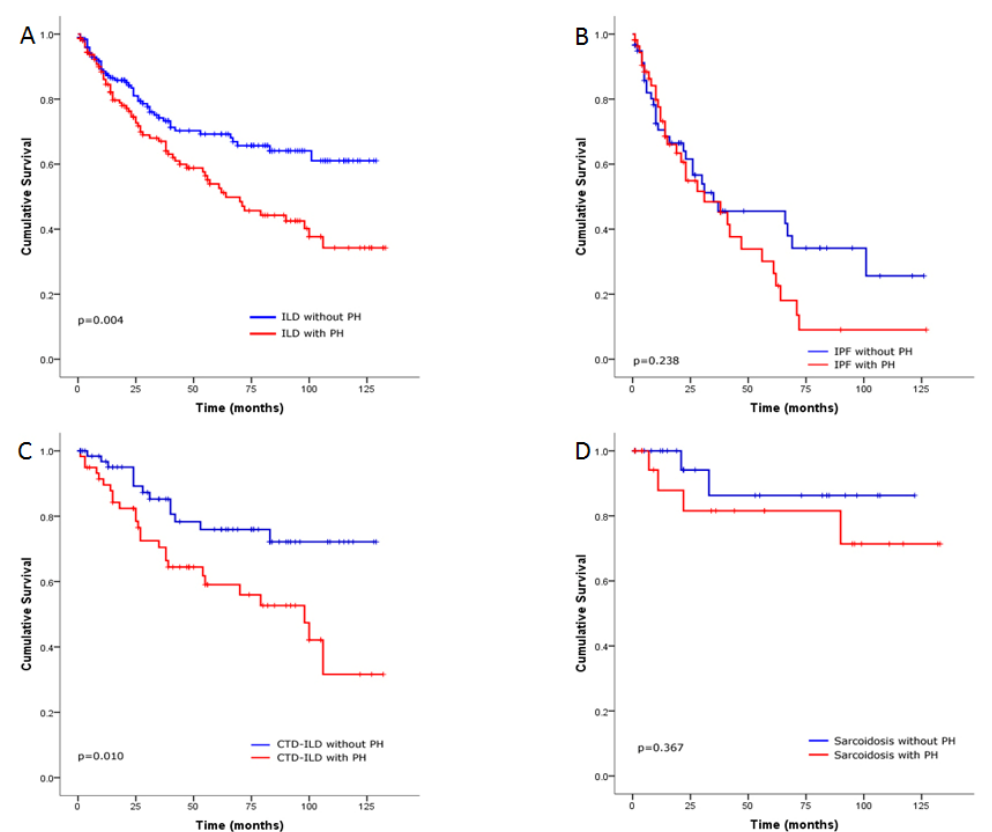
Figure 1. Kaplan–Meier survival estimates for the relationship with ( A ) interstitial lung disease (ILD) patients with and without pulmonary hypertension (PH), ( B ) idiopathic pulmonary fibrosis (IPF) patients with and without PH, ( C ) connective tissue disease (CTD) associated ILD patients with and without PH and ( D ) sarcoidosis patients with and without PH.